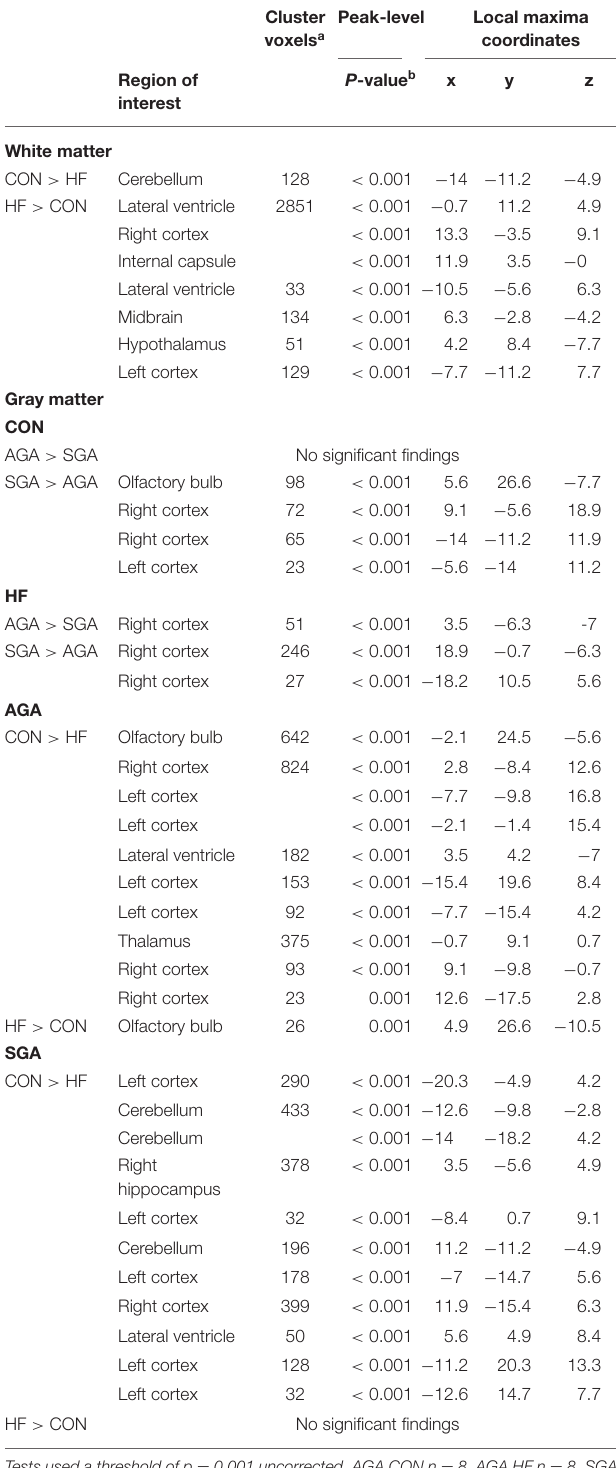
TABLE 3 | Effects of birth weight and HF on gray matter and white matter differences as determined by voxel-based morphometric analysis. Cluster voxels a